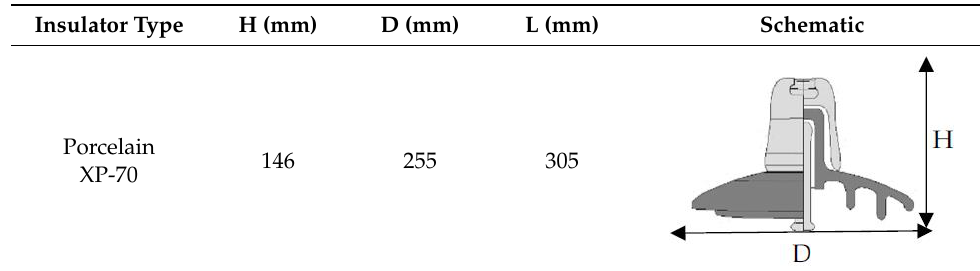
Figure 4. RTV coating damage profiles of coated insulators. Table 1. Insulators ’ technical characteristics.